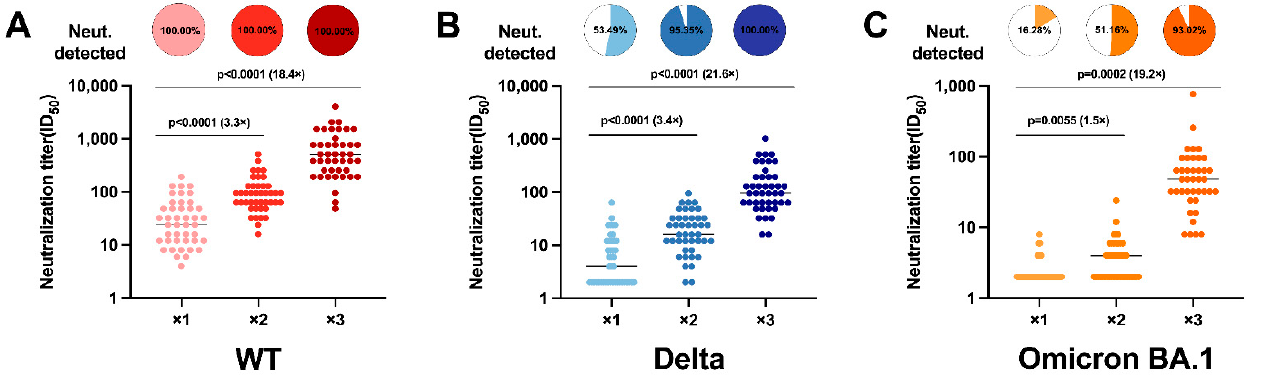
Figure 2. Live virus neutralization test results from 129 serum samples obtained from 43 volunteers vaccinated with three doses of CoronaVac homologously after each dose of CoronaVac. Neutralization of authentic viruses was performed using a cytopathic effect (CPE)-based assay with a viral titer of 10 10 TCID 50 (median tissue culture infectious dose). The neutralization titer of the serum sample was calculated as the reciprocal of the highest dilution that protected more than 50% of cells from CPE. Pie charts show the proportion of vaccinees within each group that had detectable neutralization against the severe acute respiratory syndrome coronavirus 2 (SARS-CoV-2) live virus. Fold-increase in the geometric mean neutralization titer of each dose relative to those vaccinated with one dose within a group is shown as a number with the “×” symbol above the lines. (A-C) The results of neutralizing antibodies against the wild-type (WT) ( A ), Delta ( B ), and Omicron BA.1 ( C ) viruses in the serum indicated by dots.